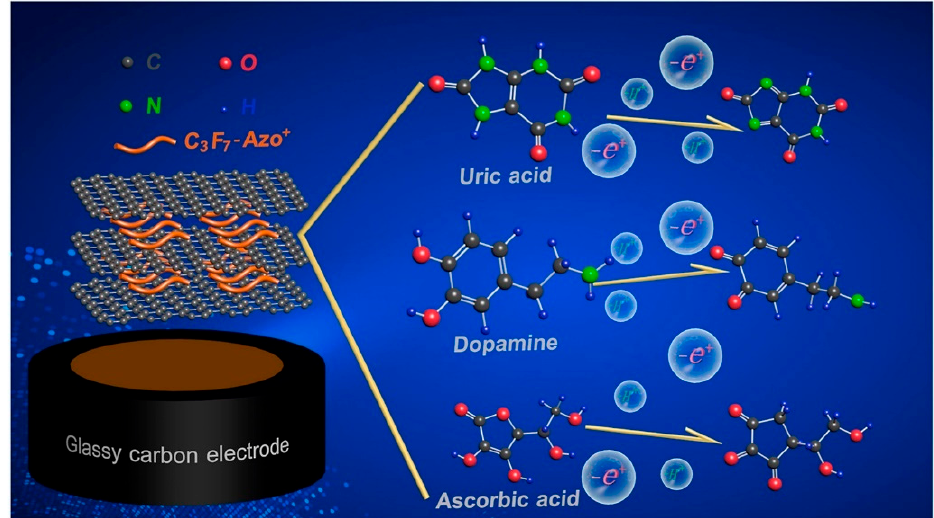
Figure 14. Cationic polyfluorinated AZO-RGO for simultaneous detection of uric acid, dopamine, and ascorbic acid [112].